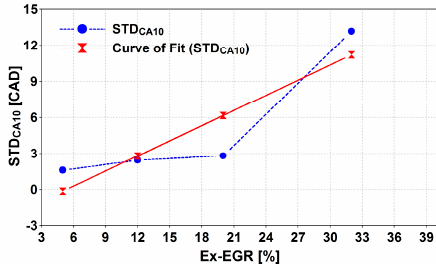
Figure 11. Cyclic variability of CA10 due to variation of Ex-EGR setting (rpm = 3000, IMEP = 2.1 bar, T epc = 525 – 530 K).